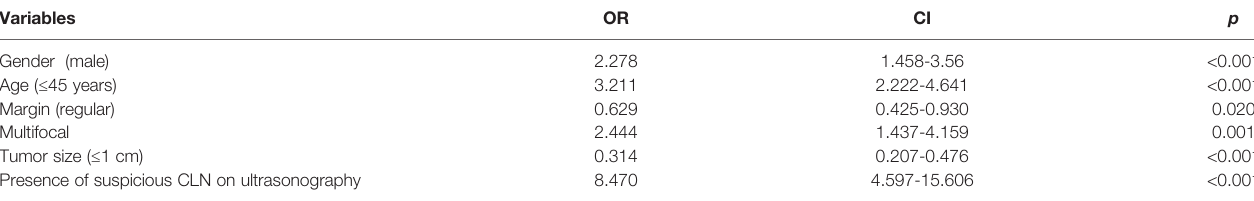
TABLE 4 | Multivariate analysis of the correlation between clinical factors of the primary tumor and rate of CLNM in all PTC patients. Variables OR